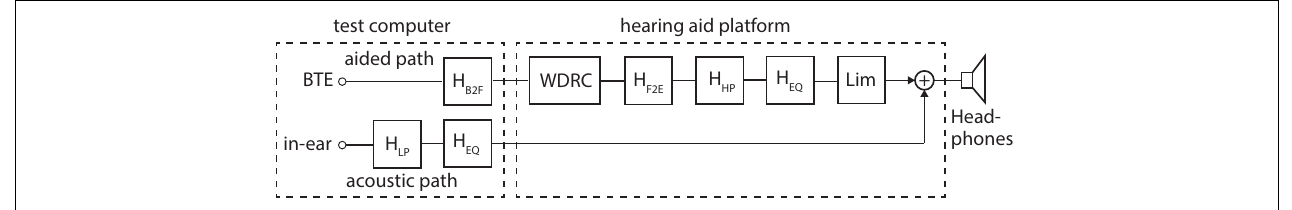
FIGURE 3 | Block diagram of the acoustic and aided signal path from the HATS’ in-ear and BTE (front) microphone to the headphones for binaural playback. Only the pathway for the left or right ear is shown here.